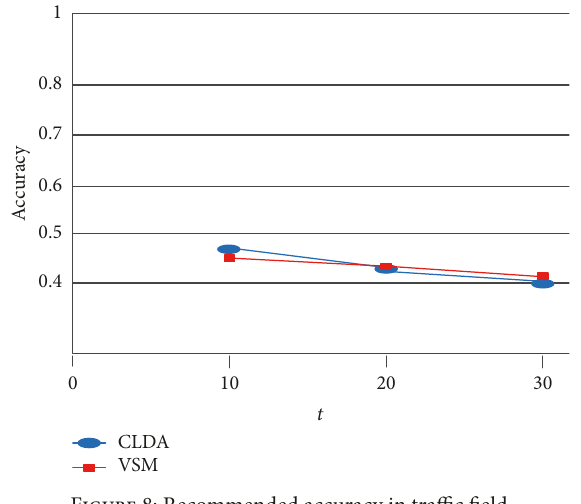
Figure 8: Recommended accuracy in traffic field.